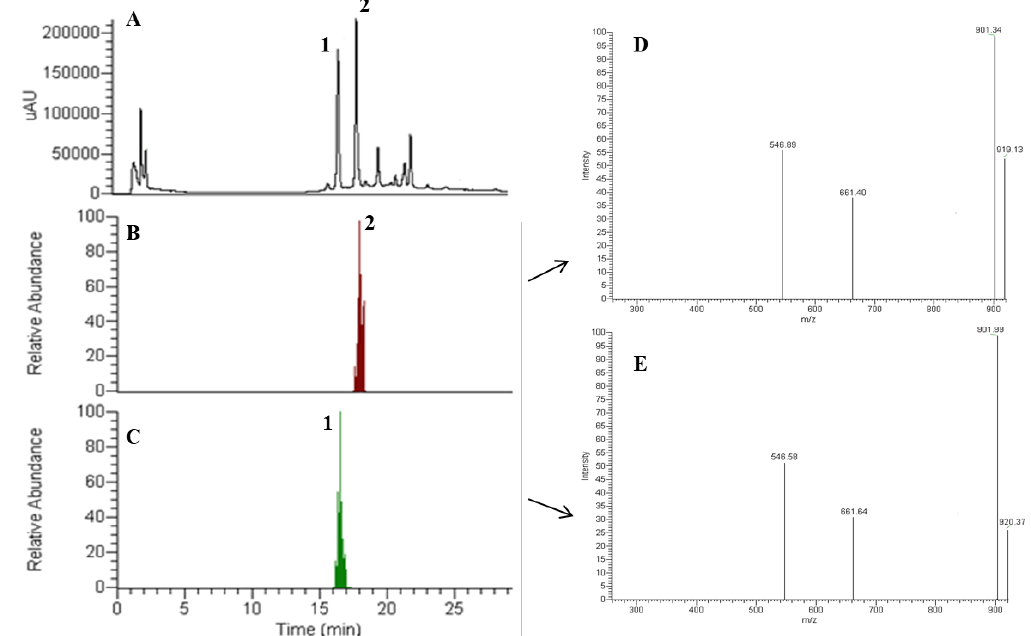
Figure 5. ( A ) HPLC-DAD chromatogram of an extract of Amanita phalloides, monitored at 305 nm, with the separation of peaks of β -amanitin (1) and α -amanitin (2). Total ion chromatogram (TIC) ( B ) and mass spectrum and fragmentation pattern ( D ) of peak 2- α -amanitin and total ion chromatogram (TIC) ( C ) and mass spectrum and fragmentation pattern ( E ) of peak 1- β -amanitin with a retention time of 18.1 and 16.6 min, respectively.